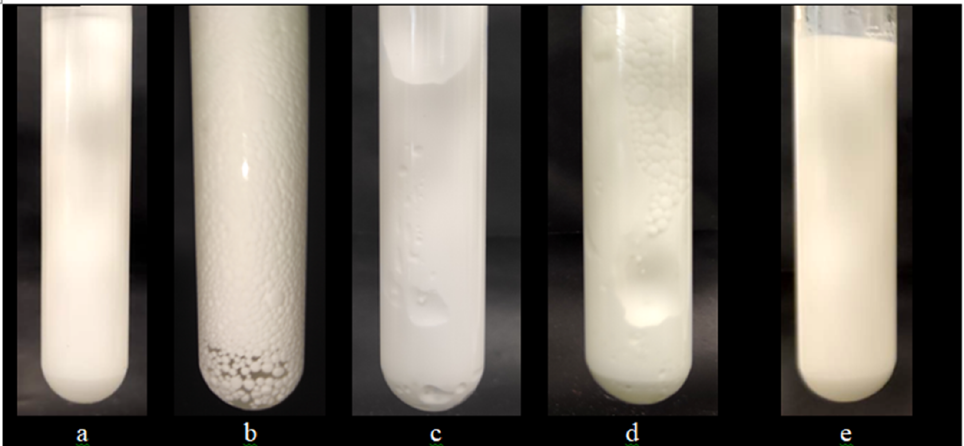
Figure 2. The emulsions containing ( a ) 50% w / w dispersed phase (distilled water) and 2% w / w PGPR, ( b ) 50% w / w dispersed phase (casein hydrolysate) and 2% w / w PGPR, ( c ) 50% w / w dispersed phase (buffer solution) and 2% w / w PGPR, ( d ) 40% w / w dispersed phase (casein hydrolysate) and 2% w / w PGPR, and ( e ) 40% w / w dispersed phase (casein hydrolysate) and 3% w / w PGPR.